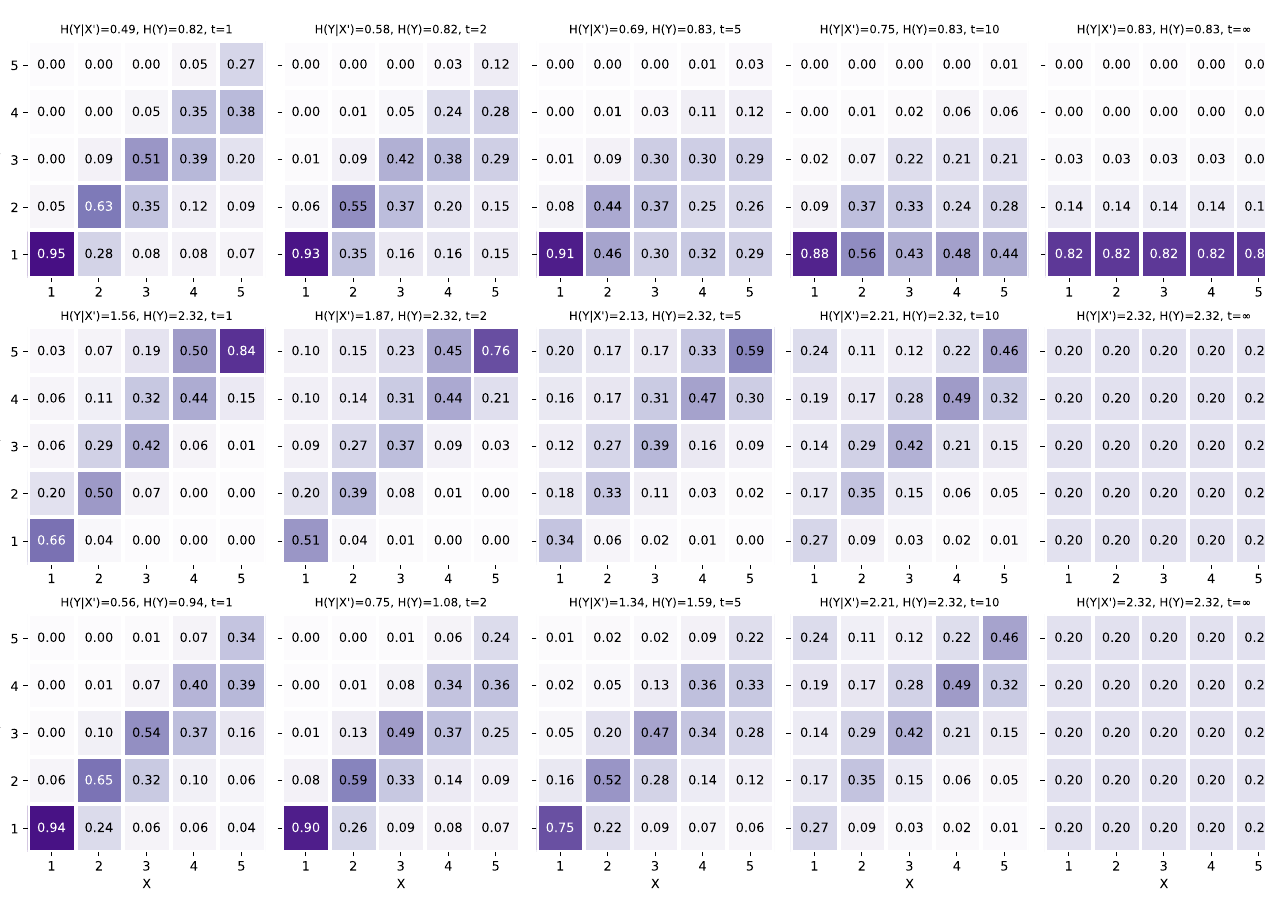
Figure 7. ( Top ) P ( Y | X (cid:48) ) of TAAS dataset. ( Middle ) P ( Y ) balanced P ( Y | X (cid:48) ) . ( Bottom ) MIR reweight- ing strategy. Smaller H ( Y | X ) corresponds to larger I ( X ; Y ) . The radar echo intensity (0–70 dBZ) is divided into five categories evenly. X and Y axes stand for the index of the